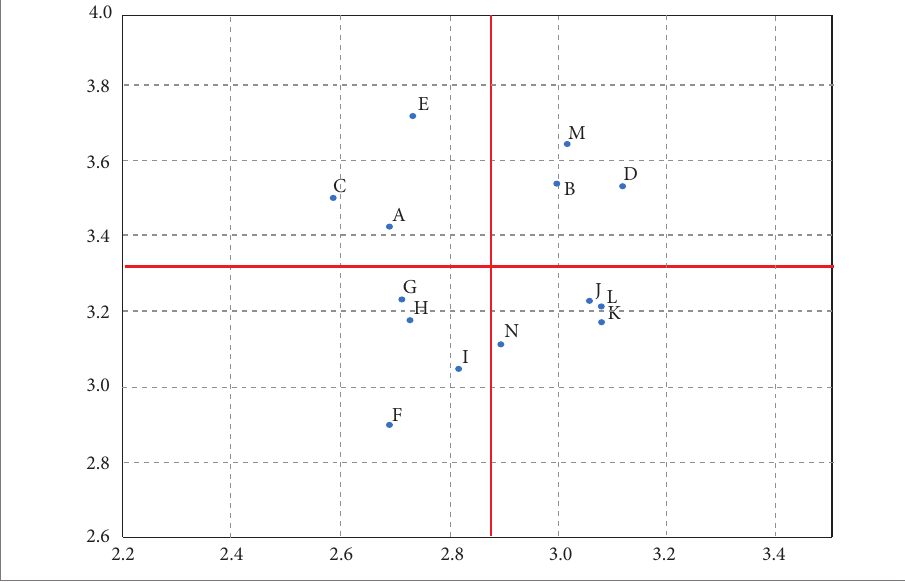
Fig. 13. The scatter diagram of parameters of relations of Ukrainian enterprises with the material supplier